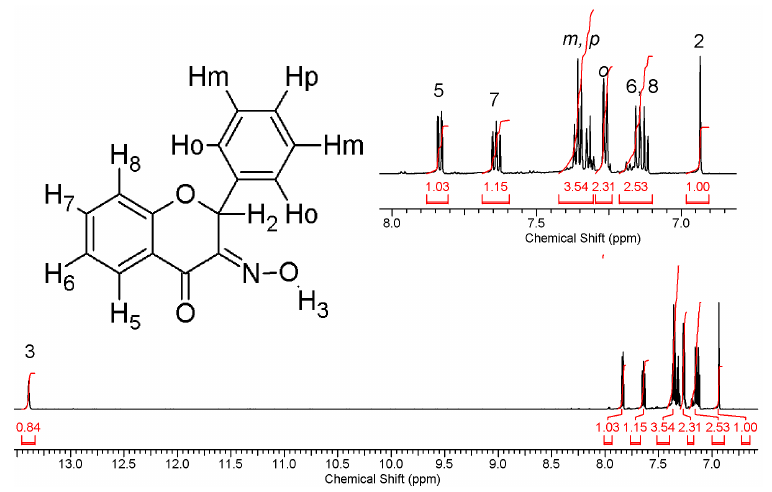
Figure 4. 1 H-NMR (Nuclear Magnetic Resonace) spectrum of 1 in DMSO- d 6 , with integration values and